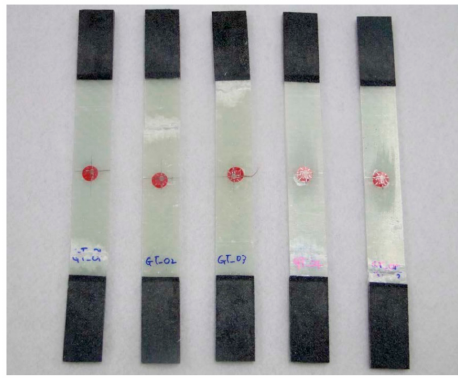
Figure 3. Fracture shape of tensile specimen.